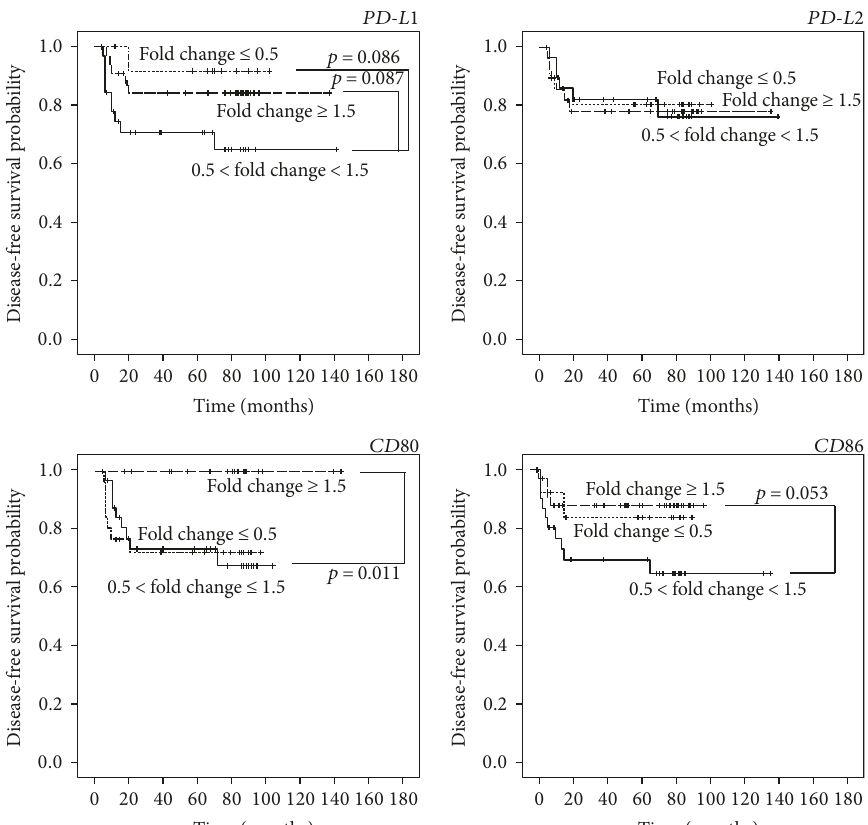
Figure 3: mRNA level of PD-L1 , PD-L2 , CD80 , and CD86 and disease-free survival (DFS) in PTC patients. Kaplan-Meier analysis combined with Mantel-Cox log-rank statistical test, performed on 79 PTC patients followed up from 5 to 141 months. Expression values of PD-1 and CTLA-4 ligands were classi fi ed as increased (fold change > 1.5), decreased (fold change < 0.5), or unchanged (0.5 ≤ fold change ≤